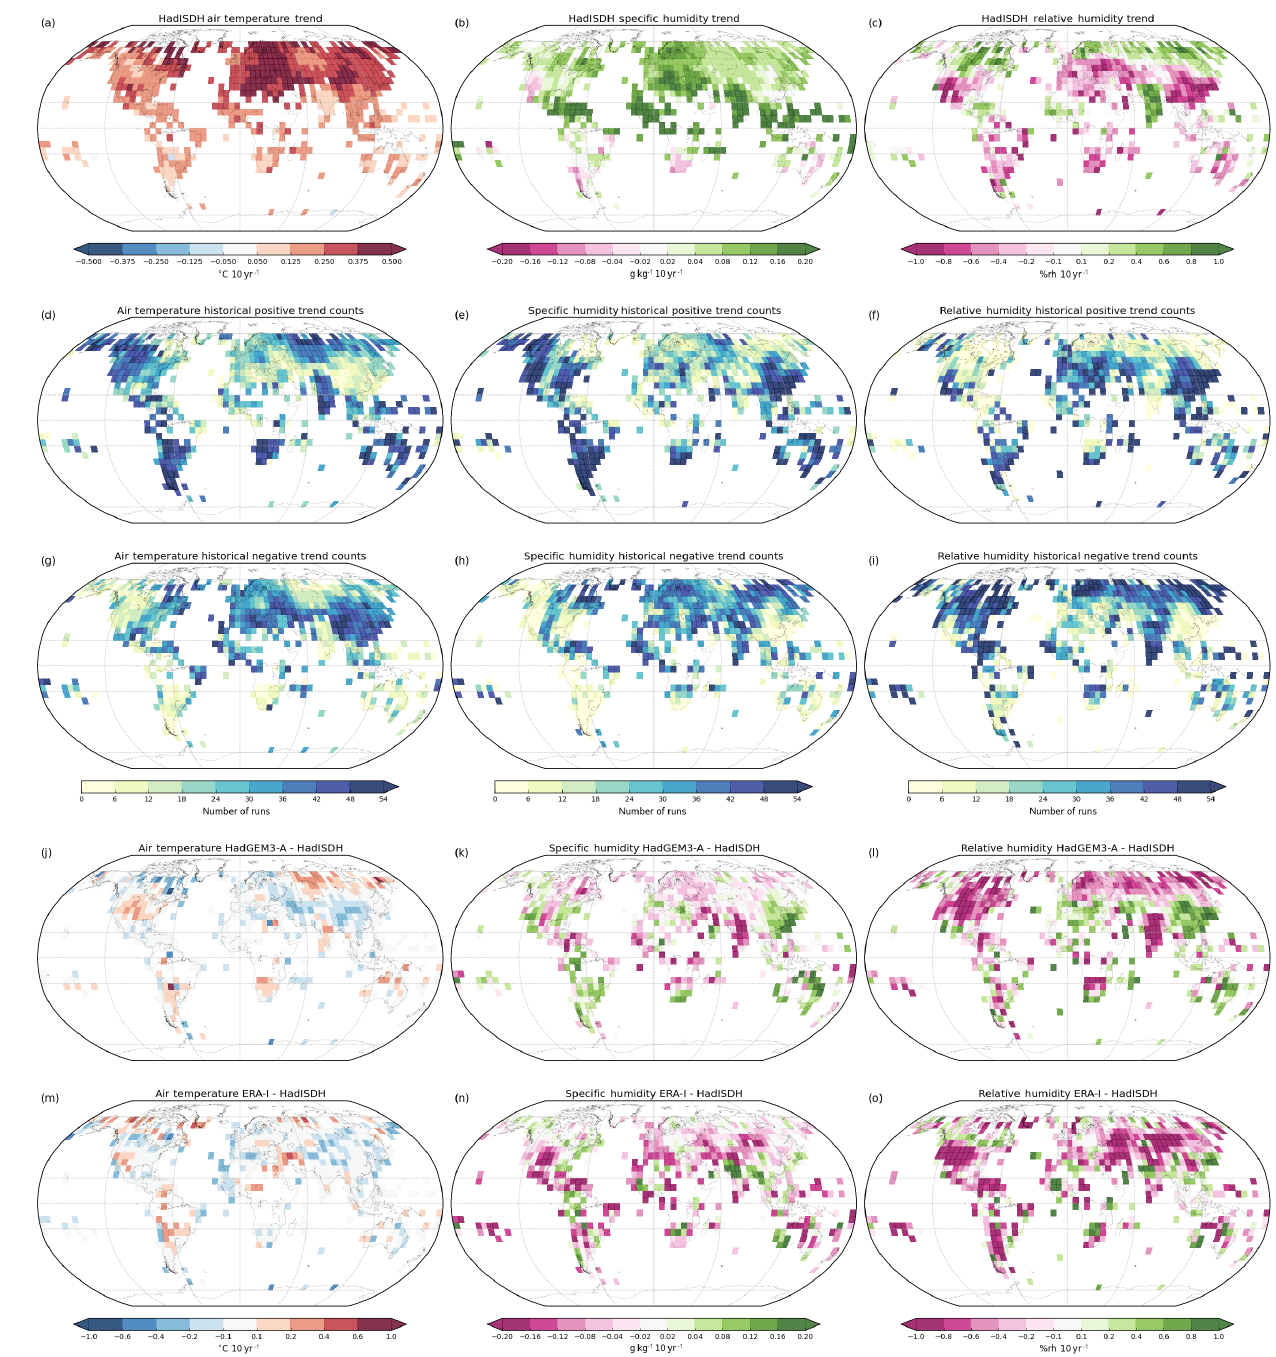
Figure 6. Differences in linear trends between models and observations on the grid box scale. (a, b, c) The HadISDH trends for comparison purposes (1975–2010 with 80% completeness). Frequency of historically forced CMIP5 models with (d, e, f) positive trends (more warming and less cooling, more moistening and less drying, becoming more saturated and a lower rate of becoming more arid) or (g, h, i) neg- ative trends (opposite to directions above) relative to HadISDH for air temperature, specific humidity and relative humidity respectively. For (d) to (i) shading scales with the multi-model mean difference of models minus HadISDH. (j, k, l) Difference (model minus observation) between HadGEM3-A and HadISDH for air temperature, specific humidity and relative humidity respectively. (m, n, o) Difference (reanal- ysis minus observation) between ERA-Interim and HadISDH for air temperature, specific humidity and relative humidity respectively. All trends have been calculated using the median of pairwise slopes method, with spatio-temporal coverage identical to HadISDH.